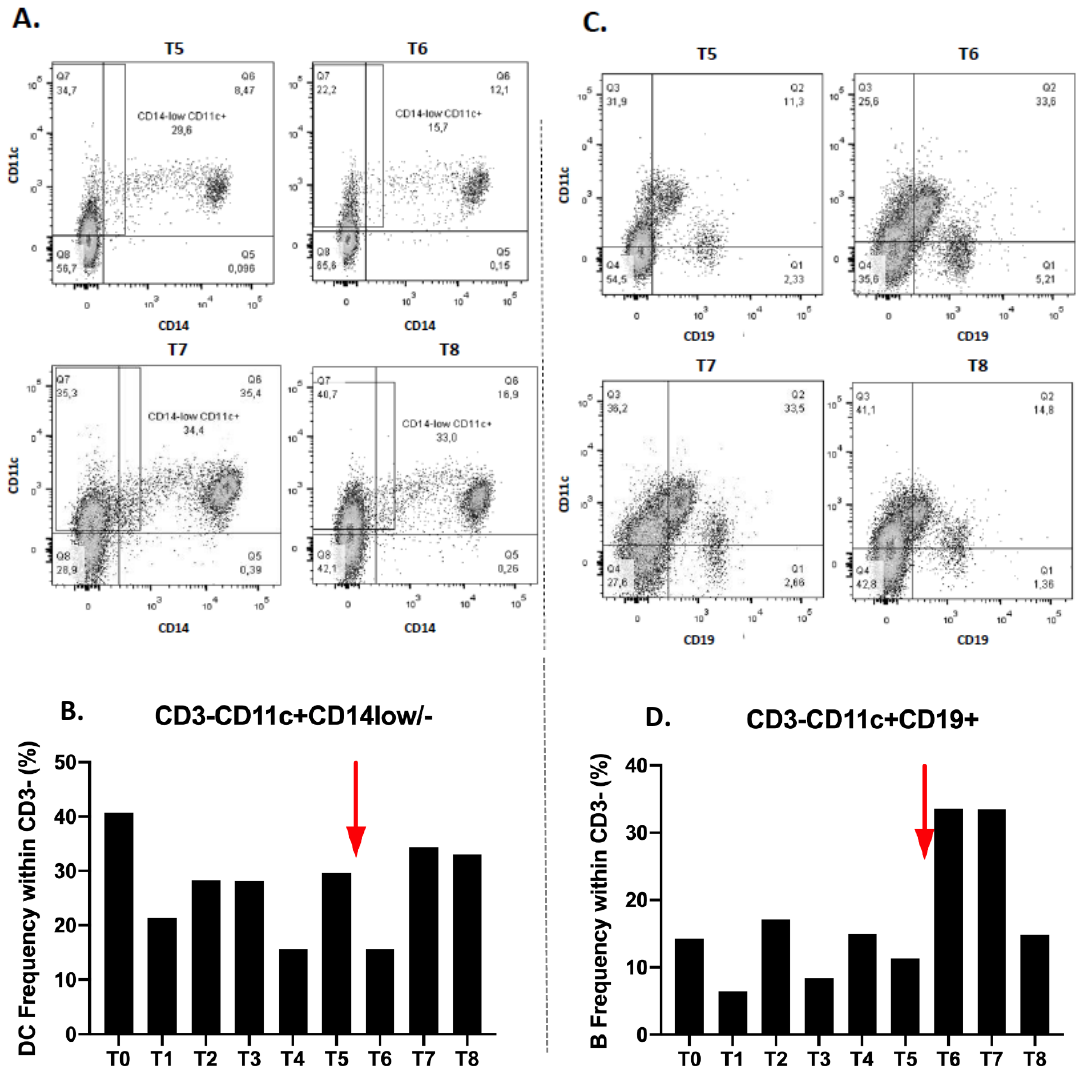
Figure 3. Gating strategy for frequency of CD11c + CD14low / - dendritic cells ( A ) and CD11c + CD19 + B lymphocytes ( C ) before (T5) and after (T6–8) Nivolumab injection (red arrow). Frequency of CD11c + CD14low / - dendritic cells ( B ) and CD11c + CD19 + B lymphocytes ( D ) in CD3-cells during all the follow up.